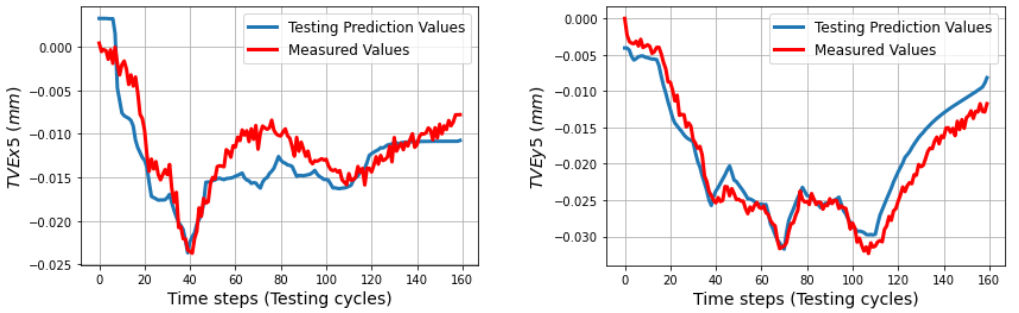
Figure 16. Prediction of TVEy9 and TVEz9 in the short process (SP) (1 cycle = 15 min).